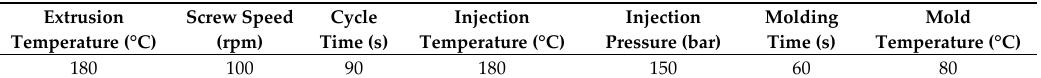
Table 2. Operating condition use for the extrusion and injection molding